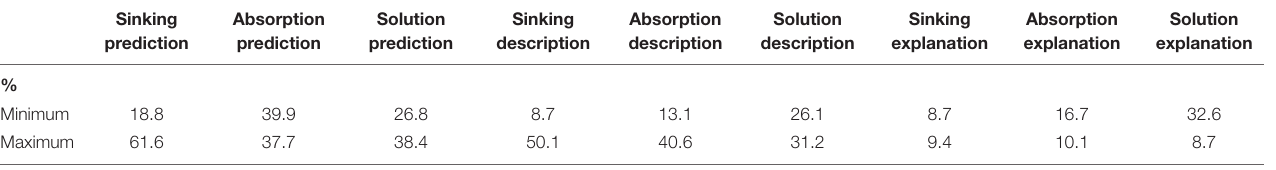
TABLE 1 | Percentages of children obtaining minimum and maximum scores on causal phenomena at each level.